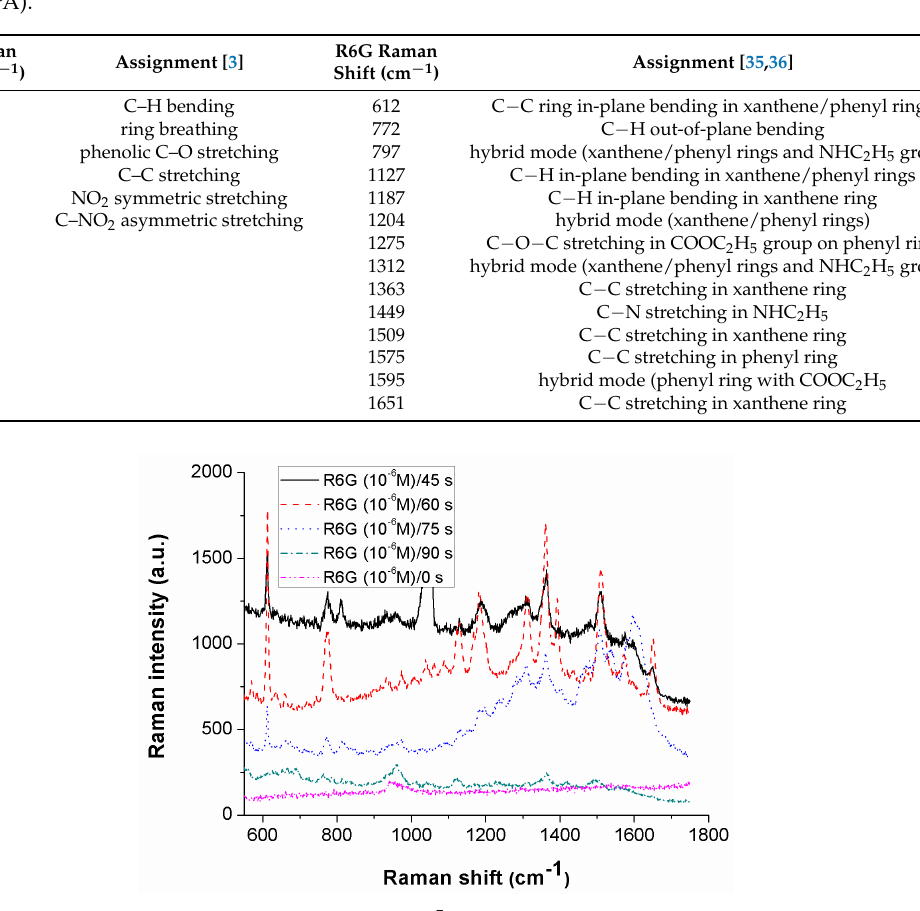
Figure 3. SERS spectra of R6G molecules (10 − 5 mol/L) on AgNP-decorated PS with different immersing times.